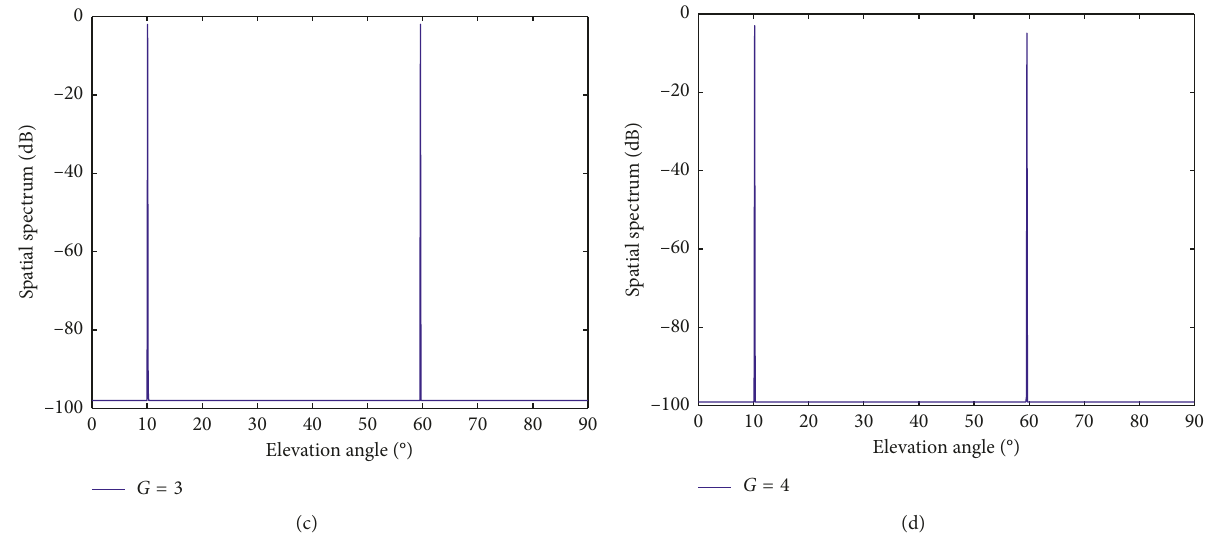
Figure 5: The elevation angle spectrum of proposed SR method under different assumed number of coherent sources (SNR � 10dB). (a)